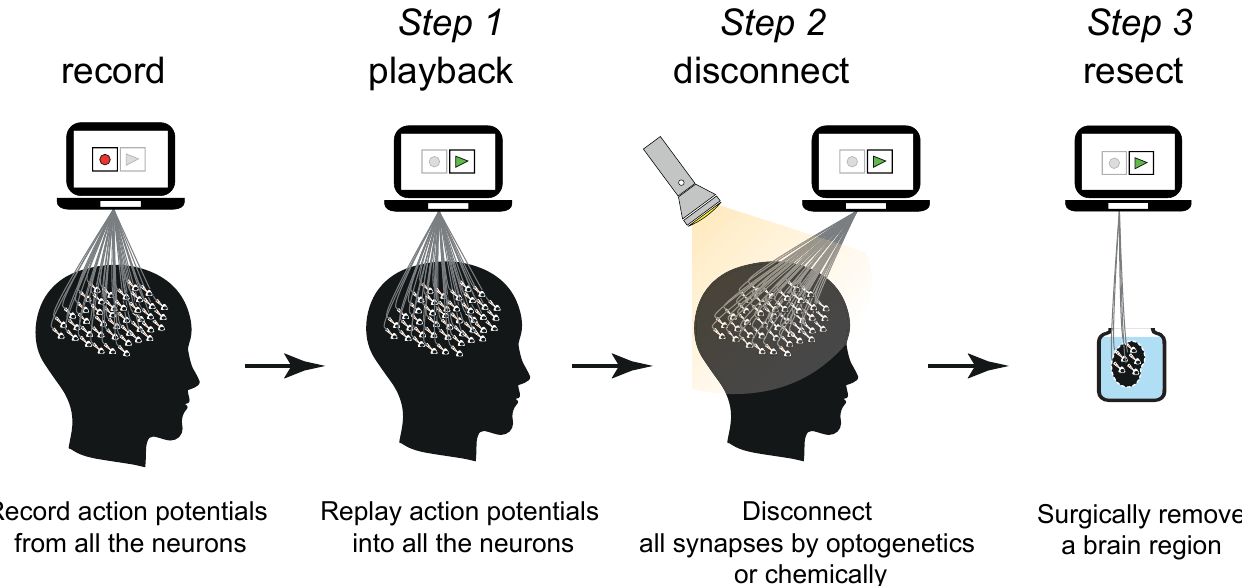
Fig 4. Summary of the experiment. Recording, replaying (Step 1), disconnecting all neurons in the brain (Step 2) and surgically removing the visual cortex (Step 3). After each step where the participant’s brain was manipulated, the reader is asked to evaluate whether or not the participant still has the conscious perception of the green